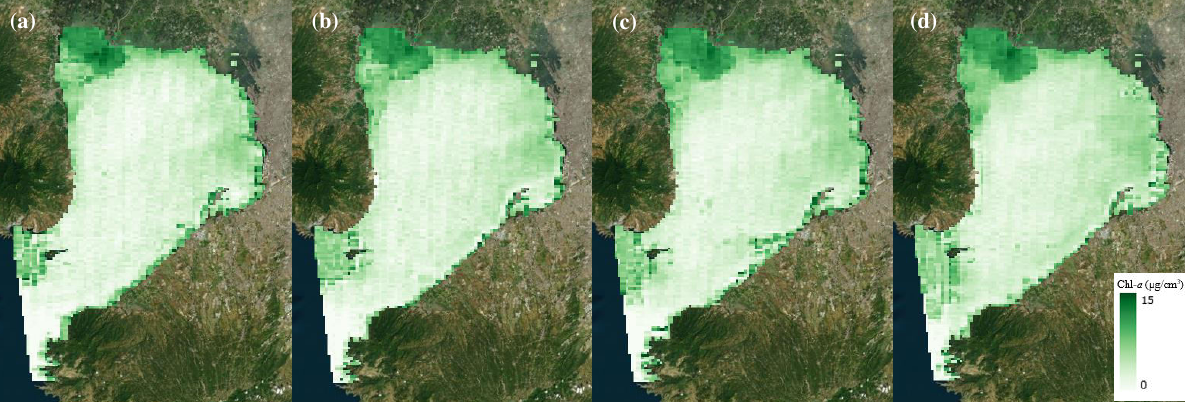
Figure 8. Chl- a maps for September 26, 2019 using the Yearly model: (a) 9:10, (b) 9:30, (c) 9:50, and (d) 10:10